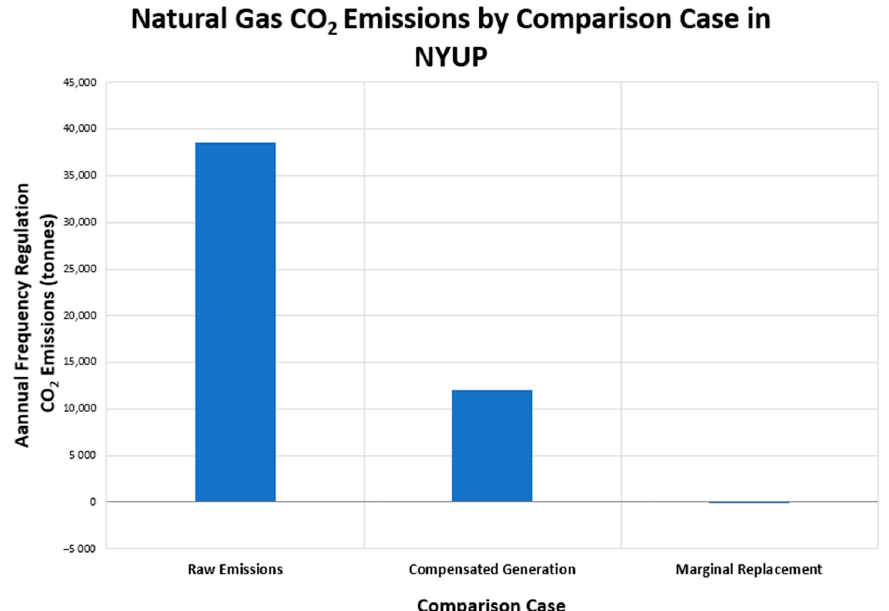
Figure 8. The annual CO 2 frequency regulation emissions in Upstate NY (NYUP) by method of crediting natural gas energy generation. Both the compensated generation case and the marginal replacement case have significantly lower emissions than the raw emissions case.